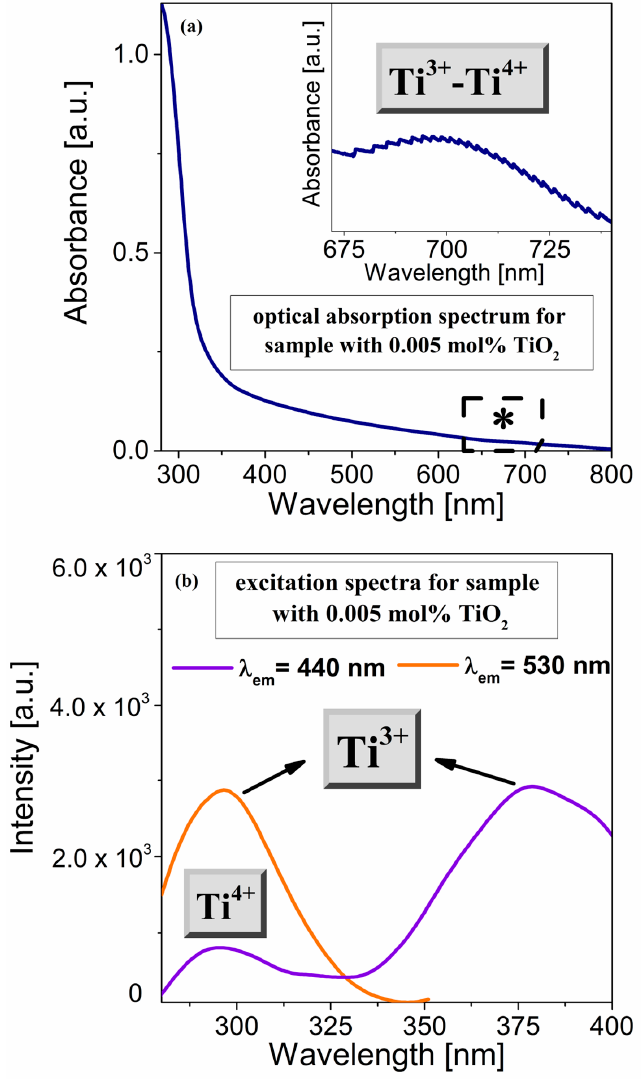
Figure 5. Optical absorption spectrum ( a ) and excitation spectra ( b ) of the sample containing ex ‐ tremely low titanium dioxide content. The excitation spectra are monitored at 440 nm and 530 nm. The inset shows Ti 3+ –Ti 4+ pair’s interaction in the range 675–730 nm (*) recorded with high resolu ‐ tion.